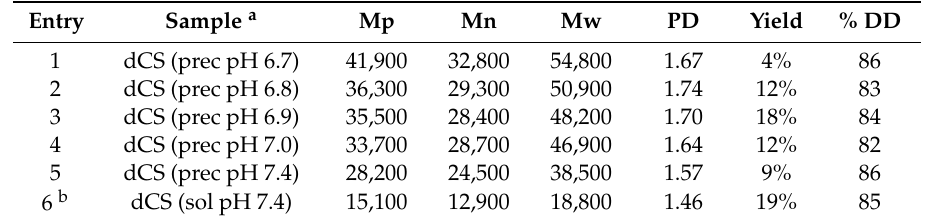
Table 4. Average molecular weights of the dCS samples neutralized to various pH levels and dialyzed in a 7 MWCO dialysis